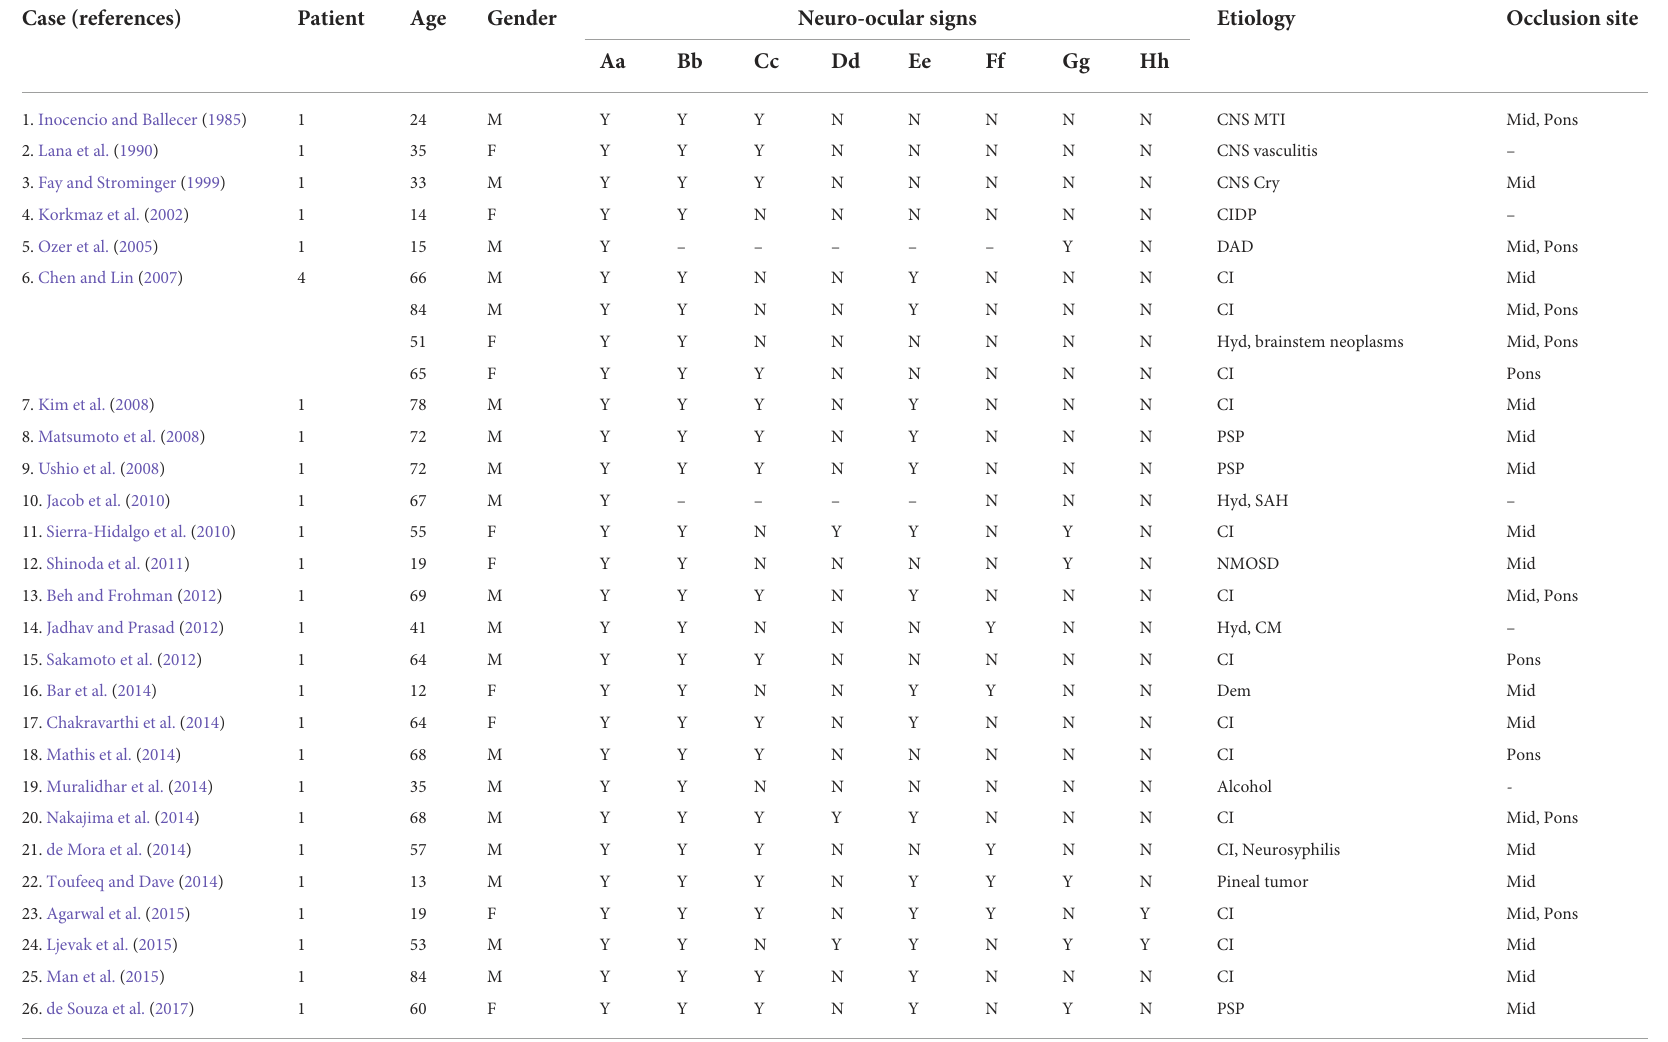
TABLE 1 Analysis of clinical data of WEBINO